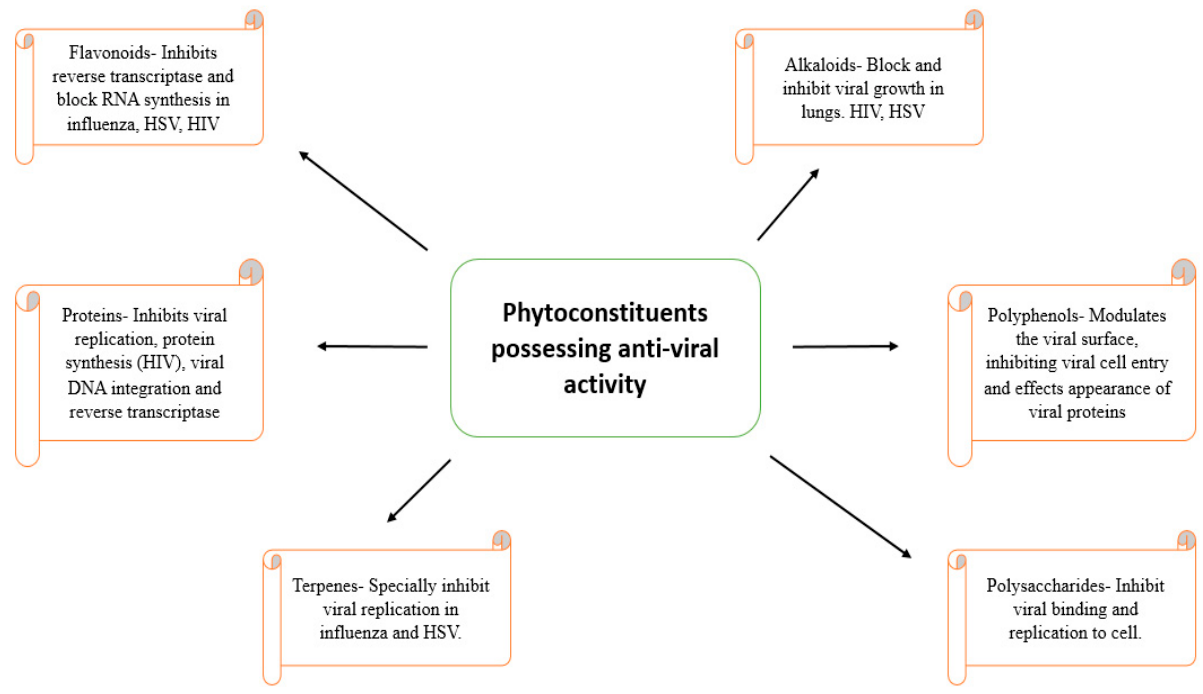
Figure 2. The activity of anti-viral phytomolecules with their mechanisms of action.